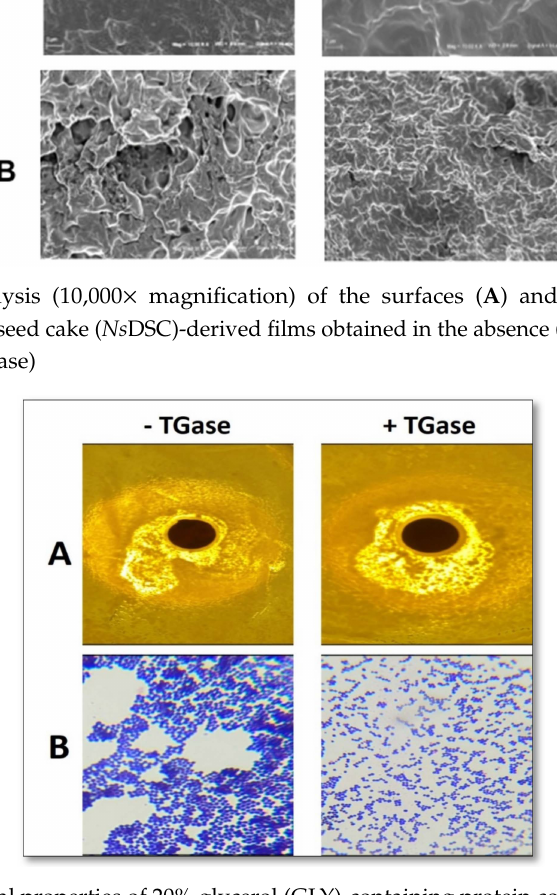
Figure 8. Antimicrobial properties of 20% glycerol (GLY)-containing protein concentrate (PC, 400 mg) films obtained from Nigella sativa defatted seed cake ( Ns DSC) at pH 8.0 after incubation of film forming solutions (FFSs) in the absence or presence of transglutaminase (TGase, 20 U / g protein). The biological e ff ect was evaluated on Staphylococcus aureus from American Type Culture Collection (ATCC) 25923 foodborne pathogenic bacterium by analyzing the growth of cells in direct contact with the film. Cells grown around PC films on mannitol salt agar after 18 h ( A ), Gram stain of the bacteria around the PC films ( B ). Further experimental details are given in the